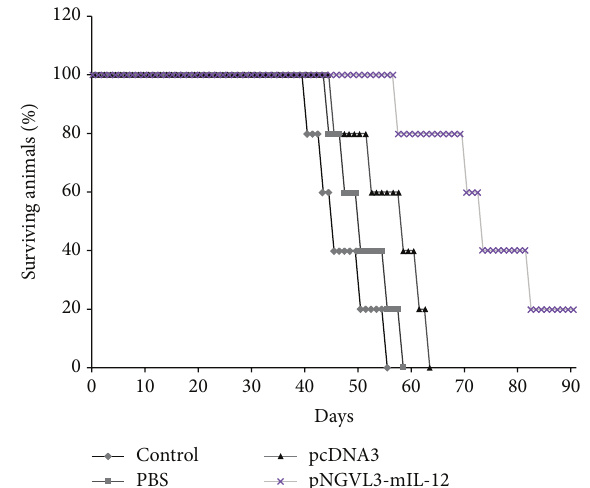
Figure 2: Long-term survival of animal after treatment. The anti- tumoral effect of IL-12 was evaluated in an HPV16-positive experi- mental tumor model. The groups of mice ( 𝑛 = 5 ) were injected with plasmid pNGVL3-mIL-12 (asterisks), pcDNA3 plasmid (triangle), PBS (square), or no treatment as control (diamond). Mouse survival was evaluated each day after the treatment, increased survival of tumor-free mice treated with IL-12 compared with